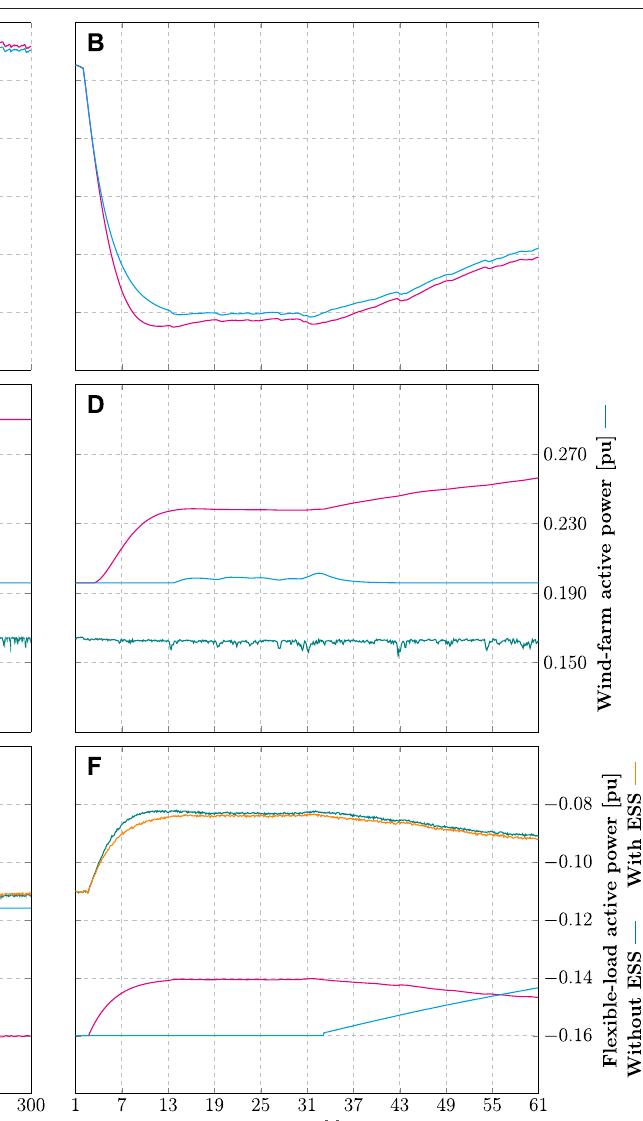
Frontiers in Energy Research |